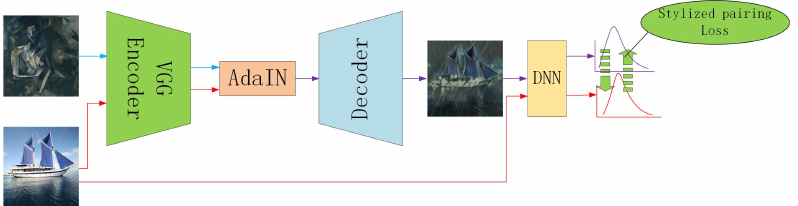
Figure 1. The architecture of our defense method based on stylized pairing: In the training process, stylized images and corresponding clear images are used to train the DNN model, and the stylized pairing loss is utilized to encourage the outputs to be as similar as possible. More details can refer to Section